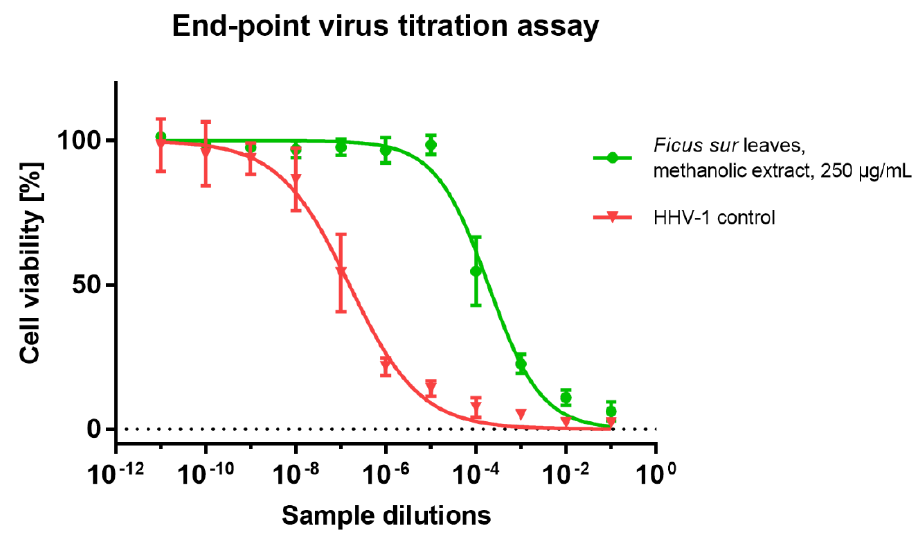
Figure 3. Influence of Ficus sur leaves methanolic extract on HHV-1 generated cytopathic effect .